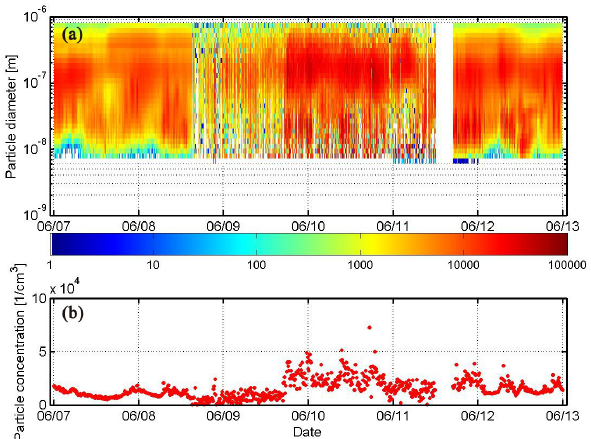
Fig. 4. (a) Aerosol size distribution measured with a differential mobility particle sizer (DMPS), (b) integrated total particle num- ber concentrations in the sub-micron size measured at the SORPES Xianlin site.